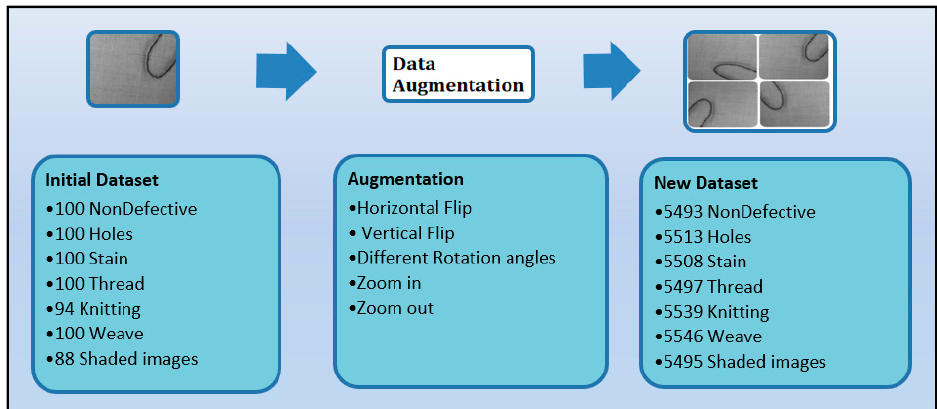
Figure 4. Representative data augmentation process.